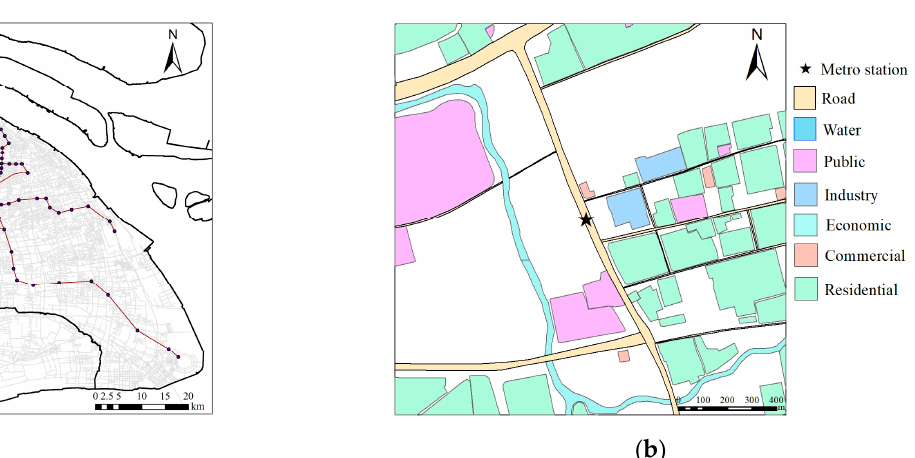
Figure 6. Map of the study area: ( a ) Distribution of the Shanghai Metro and Fanghua Road station; ( b ) Allocation of the land use around Fanghua Road Station.